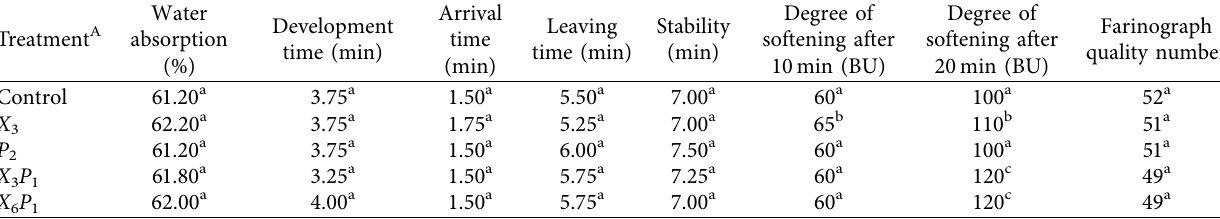
Table 2: Farinographic properties of the dough